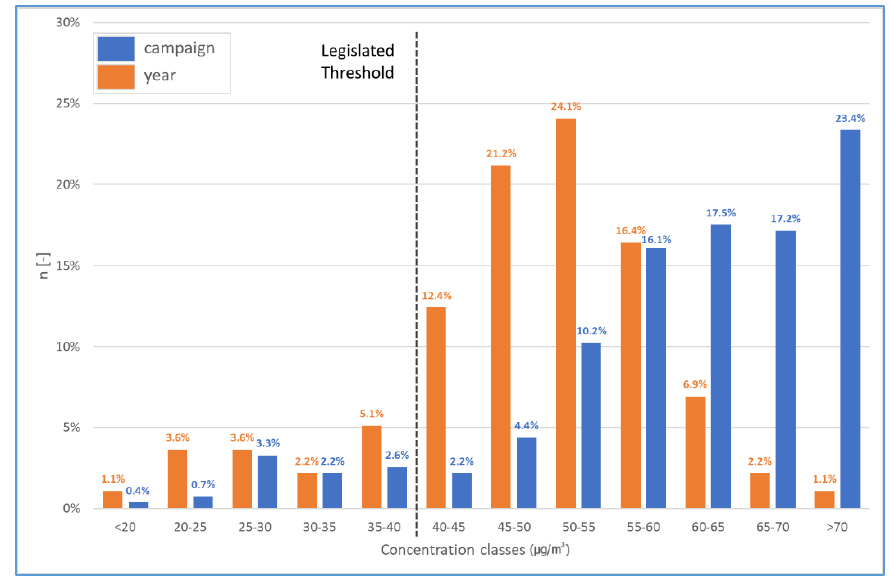
Figure 10. Distribution of #CHEARIATIRA samples for the campaign period (blue) and annual projection